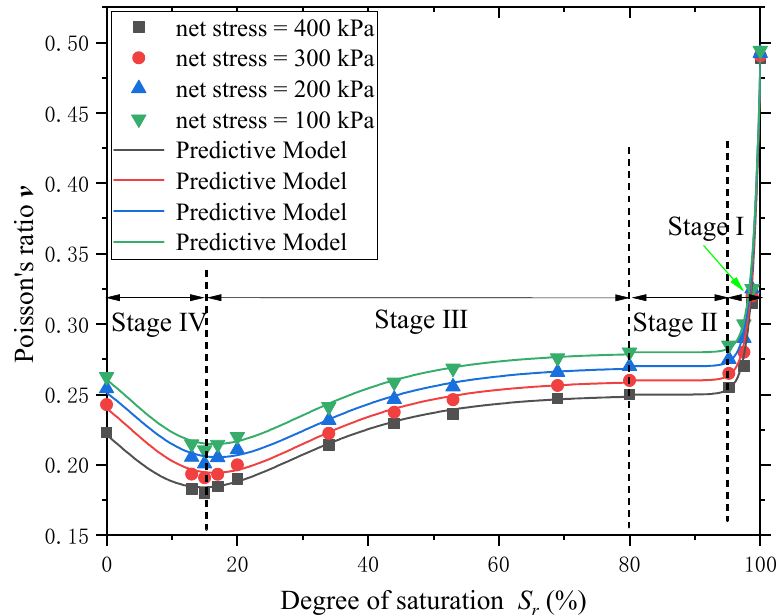
Figure 10. Poisson’s ratio variation curve with saturation and predictive model.